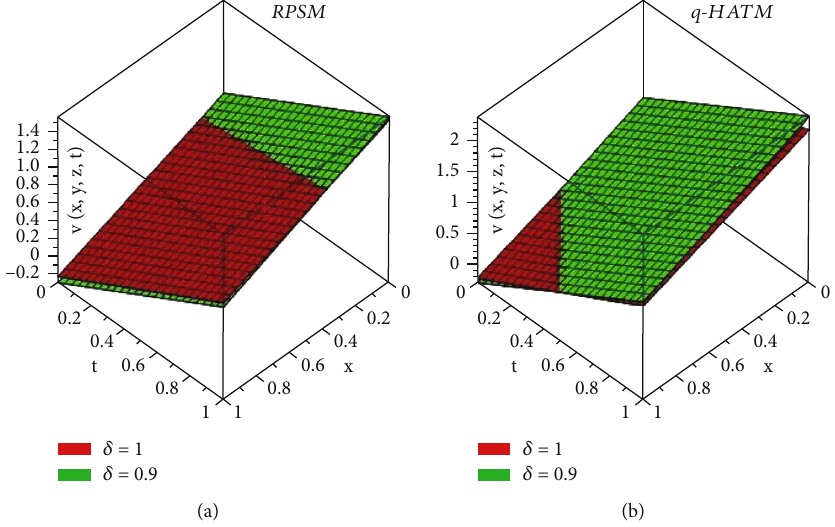
Figure 6: The 3D plots at fractional order δ of Example